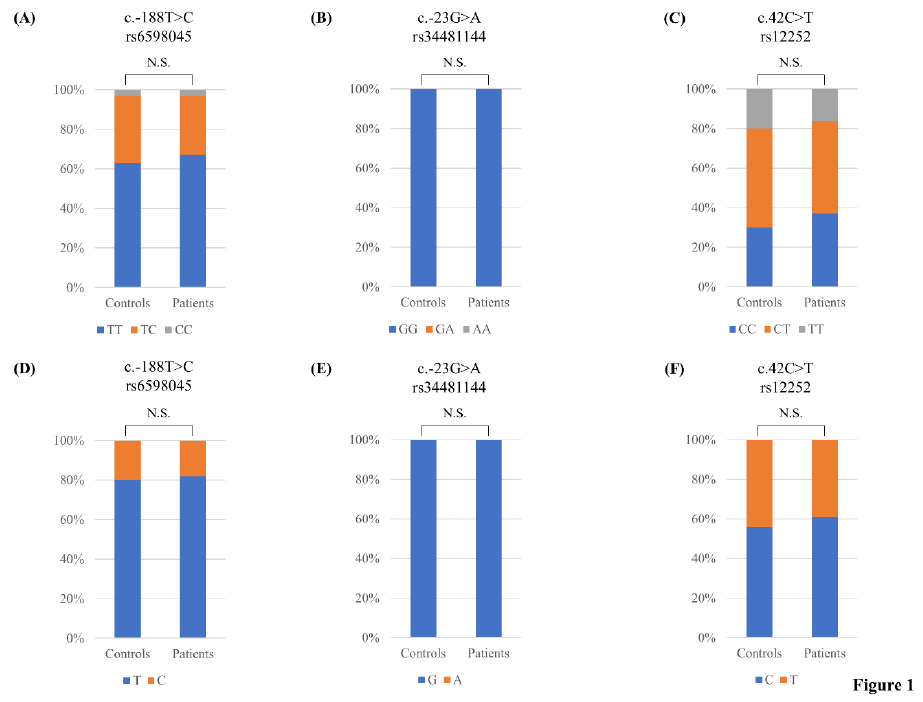
Figure 1. Comparisons of the genotype and allele frequencies of rs6598045, rs34481144 and rs12252 single nucleotide polymorphisms (SNPs) of the interferon-induced transmembrane protein 3 (IFITM3) gene in AD patients and matched healthy controls: ( A ) Comparison of the genotype fre- quency of the rs6598045 SNP of the IFITM3 gene between these two groups; ( B ) Comparison of the genotype frequency of the rs34481144 SNP of the IFITM3 gene between these two groups; ( C ) Comparison of the genotype frequency of the rs12252 SNP of the IFITM3 gene in these two groups; ( D ) Comparison of the allele frequency of the rs6598045 SNP of the IFITM3 gene between these two groups; ( E ) Comparison of the allele frequency of the rs34481144 SNP of the IFITM3 gene between these two groups; ( F ) Comparison of the allele frequency of the IFITM3 rs12252 SNP between these two groups. N.S.: not significant. Next, we performed haplotype analysis of 10 polymorphisms within the IFITM3 gene, namely, c.-223C > G, c.-204G > T, c.-188T > C, c.-181T > C, c.-178A > C, c.-175T > C, c.-128C > T, c.-13_-4DelTTCGCTGGAC, c.42C > T and c.165C > T, in AD patients and healthy controls. All haplotypes showed similar distributions ( p value > 0.5) in AD pa- tients and healthy controls (Table 3). Table 3. Haplotype frequencies of IFITM3 polymorphisms in the healthy controls and Alzheimer’s disease (AD) patients. Haplotype